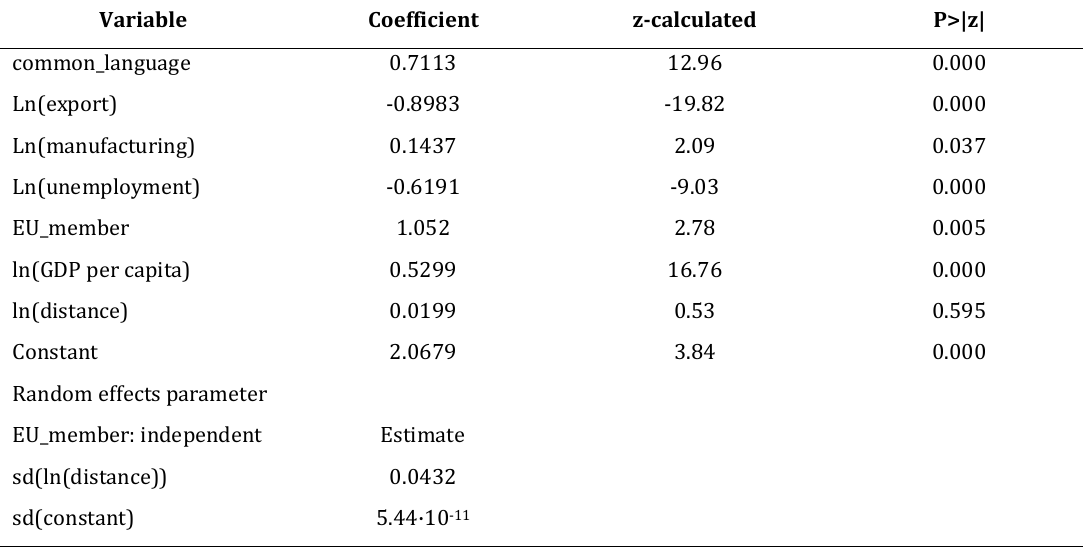
Table 4: Mixed-effects Poisson model (M3) for explaining the number of FDI projects in the UK (2012-2015)